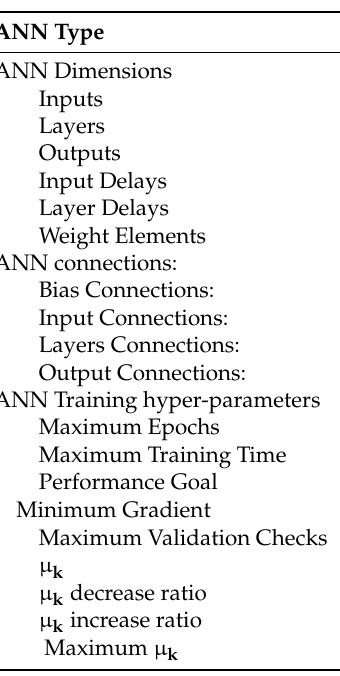
Table 1. Design parameters of the specific type of FF ANN applied, along with the hyper-parameter values related to the training